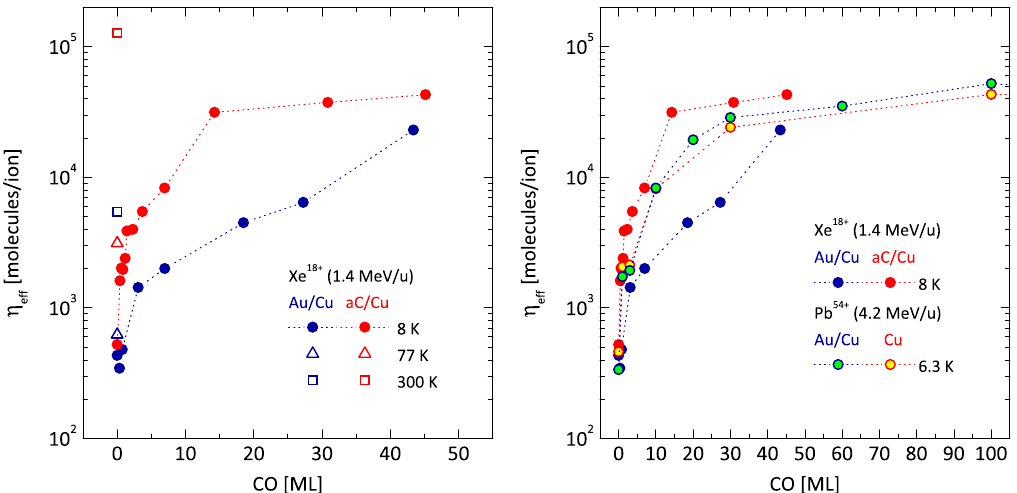
FIG. 9. Left: Heavy-ion-induced desorption yields as a function of adsorbed CO monolayers on gold-coated and amorphous-carbon- coated copper surfaces bombarded at 8 K with 1 : 4 MeV = u Xe 18 þ ions under (cid:2) ¼ 0 (cid:2) . Right: comparison with LINAC 3 desorption data obtained for 4 : 2 MeV = u Pb 54 þ ions bombarding under (cid:2) ¼ 0 (cid:2) bare and gold-coated copper targets at 6.3 K